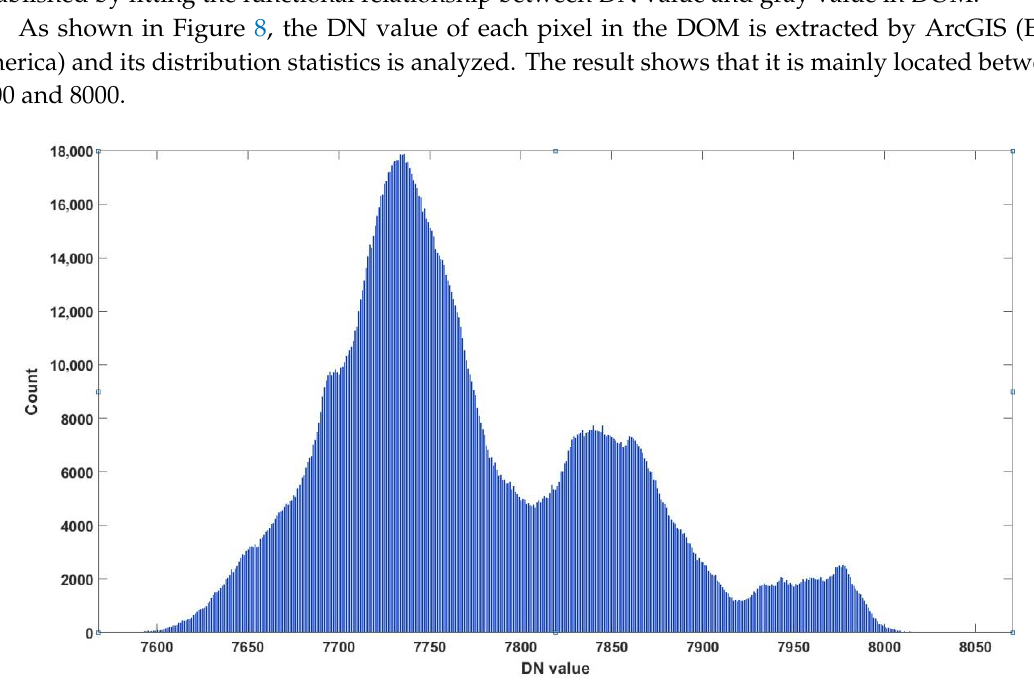
Figure 7. Images of ( a ) the 3D model in gray, and ( b ) the 3D model in color in Pix4Dmapper.